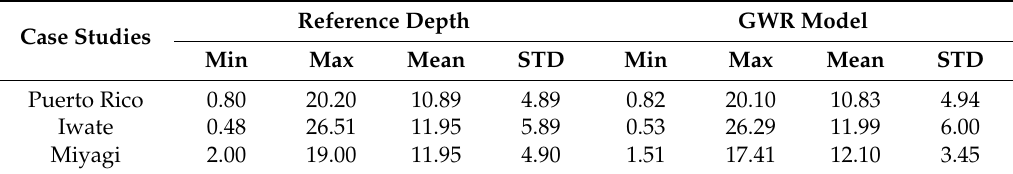
Table 4. Statistical differences between reference depth and SDB in case studies 1, 2, and